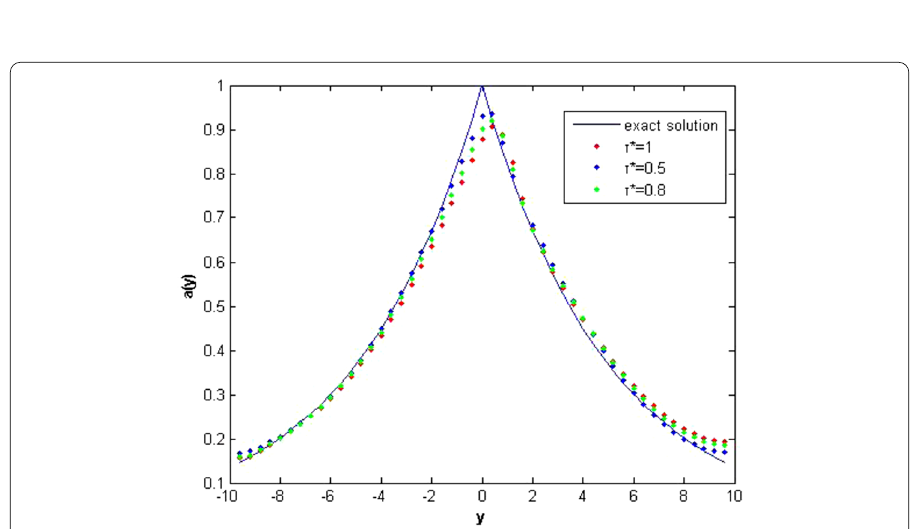
Figure 3 Identified drifts for Example 2 (iterative number